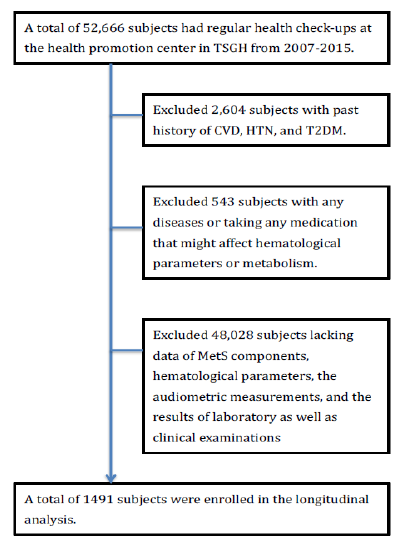
Figure 1. Description of the study flowchart. TSGH, Tri-Service General Hospital, CVD, cardiovascular disease, T2DM, type 2 diabetes mellitus, HTN, hypertension.